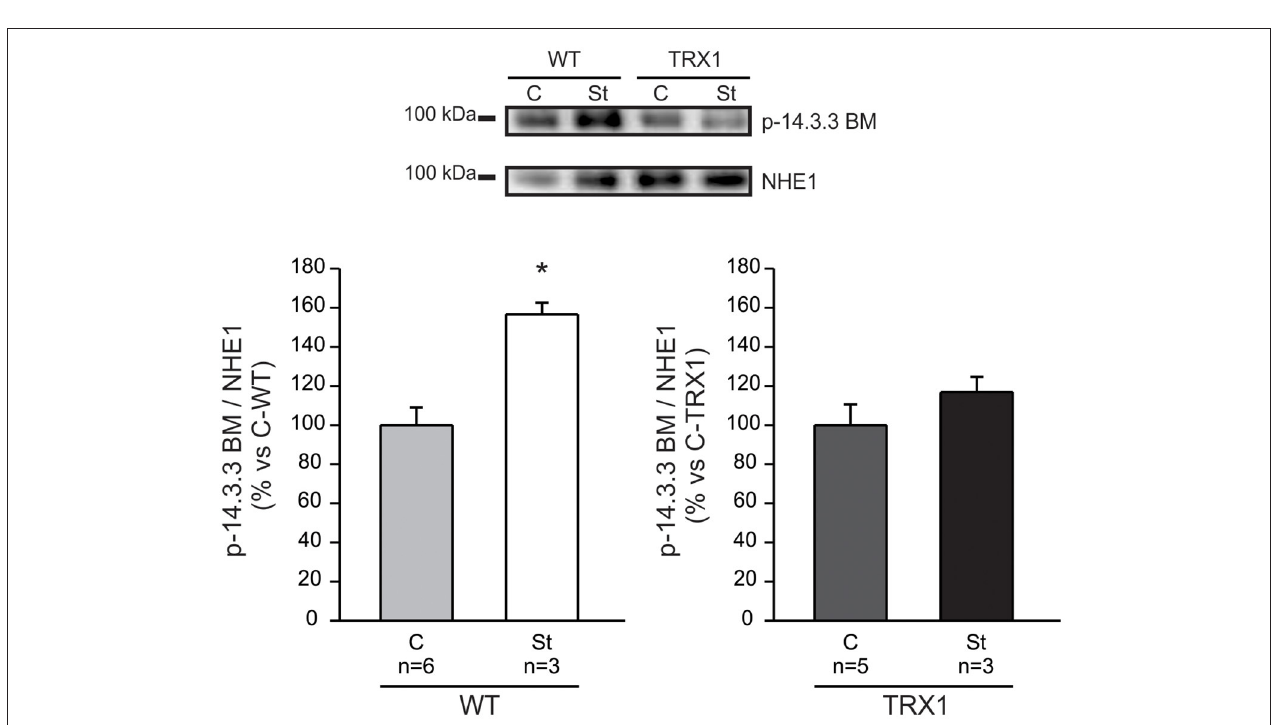
FIGURE 1 | SFR development of isolated papillary muscles from WT and TRX1-overexpressing mice. (A) Original force record of an isolated papillary muscle from a WT mouse that was suddenly stretched from 92 to 98% of L max . The characteristic two-phase increase in force that follows myocardial stretch can be observed. Individual traces corresponding to developed force indicated in the upper panel with “a” (before stretch), “b” (immediately after stretch), and “c” (10min after stretch) are shown in the bottom panel. (B) Same as A, but in a papillary muscle from a TRX1-overexpressing mouse where the SFR development was completely canceled. (C) Averaged SFR results after 10min of stretch from both experimental groups, expressed as percent of the initial rapid phase. *Indicates p < 0.05 vs. WT.